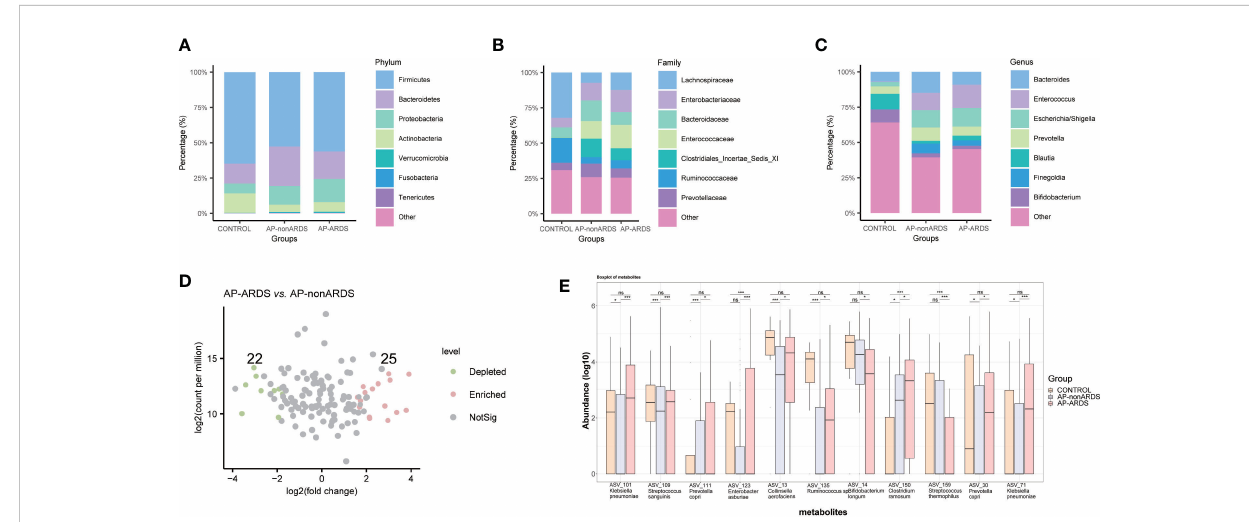
FIGURE 2 Gut microbiota composition at (A) phylum, (B) family, (C) genus levels. (D) Different amplicon sequence variants (ASVs) between AP-ARDS and AP- nonARDS group. (green= depleted in AP-ARDS group; red = enriched in AP-ARDS group; gray = no signi fi cantly difference). (E) Relative abundances of different species between AP-nonARDS and AP-ARDS groups. * P < 0.05; *** P < 0.001; ns: not signi fi